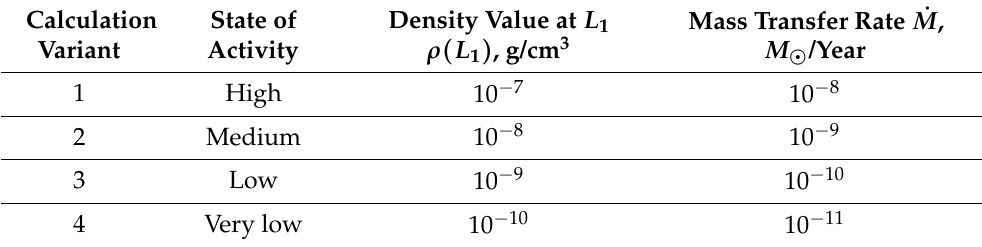
Table 2. A numerical calculation variants for the synchronous polar V808 Aur.